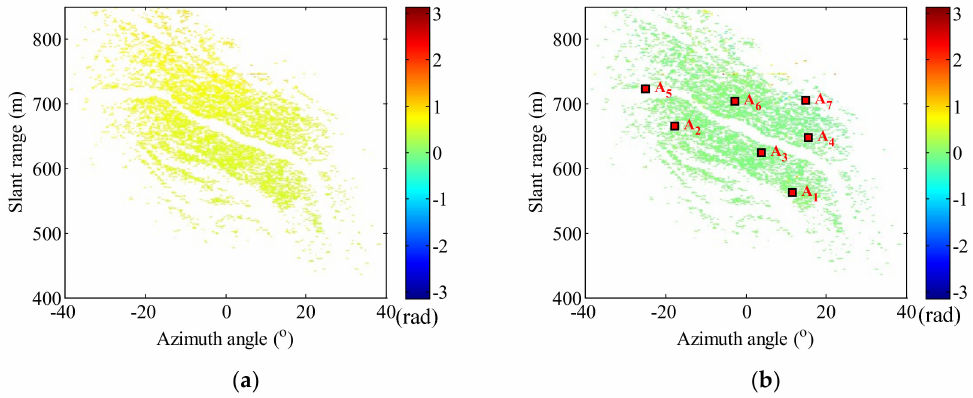
( 30 ) of Group A. ( a ) The estimated AP map. ( b ) The A